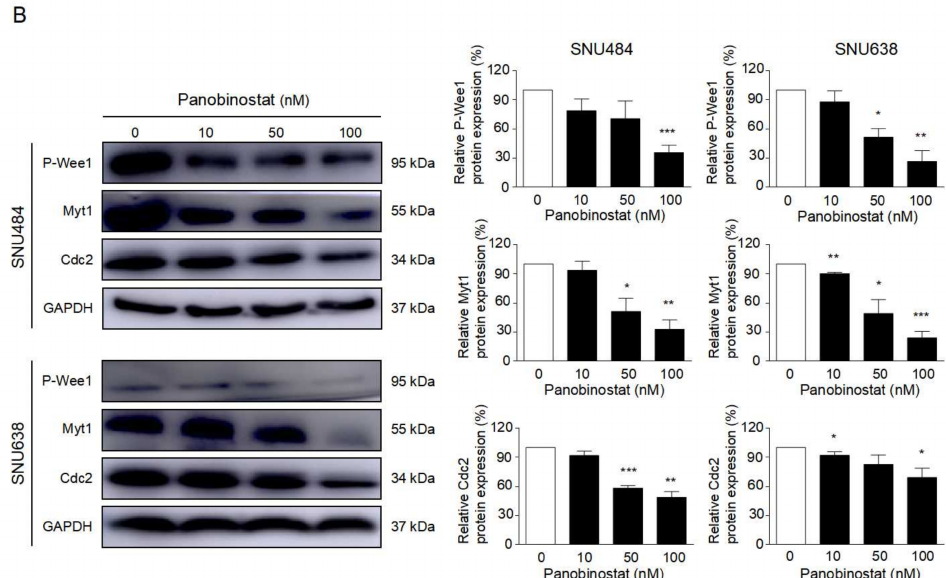
Figure 3. Panobinostat regulates cell cycle progression in gastric cancer cells. SNU484 and SNU638 cells were treated with panobinostat (0, 10, 50, and 100 nM). ( A ) Cell cycle distribution was detected by PI staining and flow cytometry and calculated as the percentage of cells in the G1, S, and G2/M phases. The scatter plots of the cell cycle show that the proportion of cells in the G1 phase was dose-dependently decreased by panobinostat. The fraction of cells in the G2/M phase was dose-dependently increased by panobinostat treatment. Data represent the mean ± SE of three independent experiments. * p < 0.05, ** p < 0.01, and *** p < 0.001 compared with the control. PI, propidium iodide. ( B ) Panobinostat affected the expression of cell cycle regulatory proteins. SNU484 and SNU638 cells were treated with panobinostat (0, 10, 50, and 100 nM) for 48 h. p-Wee1, Myt1, and Cdc2 levels were analyzed by Western blotting. GAPDH was used as an internal control. The Western blot band intensity was quantitatively analyzed using ImageJ software (NIH, Bethesda, MD, USA). Data represent the mean ± SE of three independent experiments. * p < 0.05, ** p < 0.01, and *** p < 0.001 compared with the control.